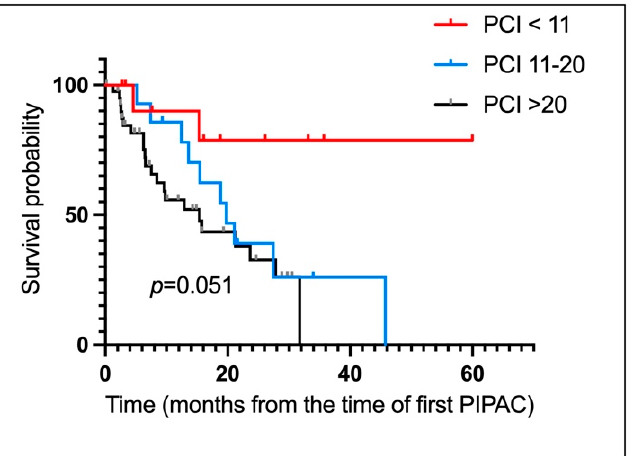
Figure 3. Survival of patients undergoing Pressurized IntraPeritoneal Aerosol Chemotherapy for peritoneal metastases of appendiceal origin. OS for the entire cohort from time first PIPAC stratified by PCI. (PCI < 11, 11–20, >20). PCI < 11: NA (5.00-NA). PCI 11–20: 20.00 Months